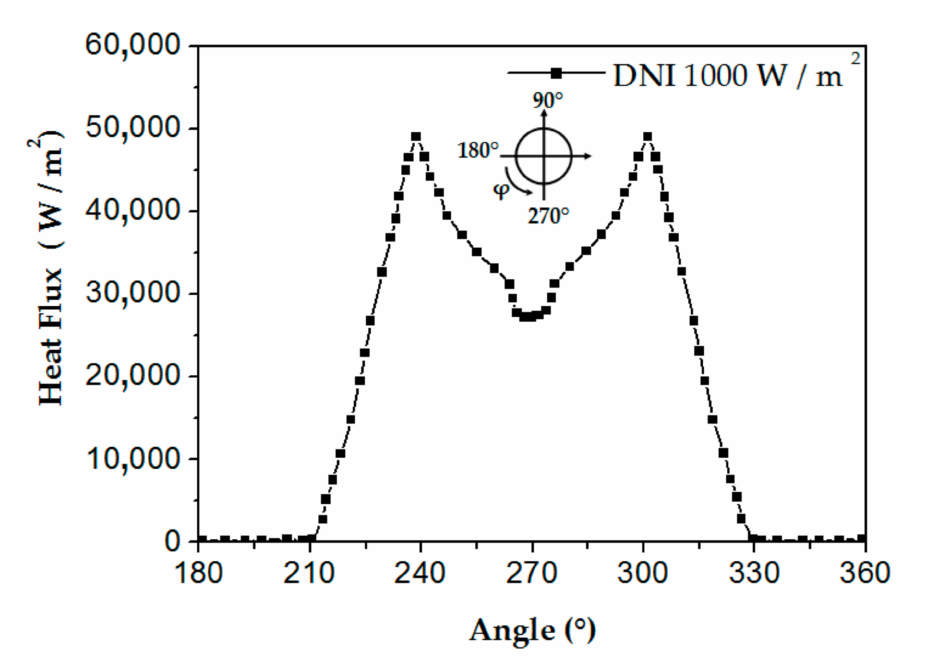
Figure 3. Heat flux distribution fluctuation throughout the absorber tube’s bottom half perimeter [54]. Reproduced with permission from [54]. Elsevier, 2013.